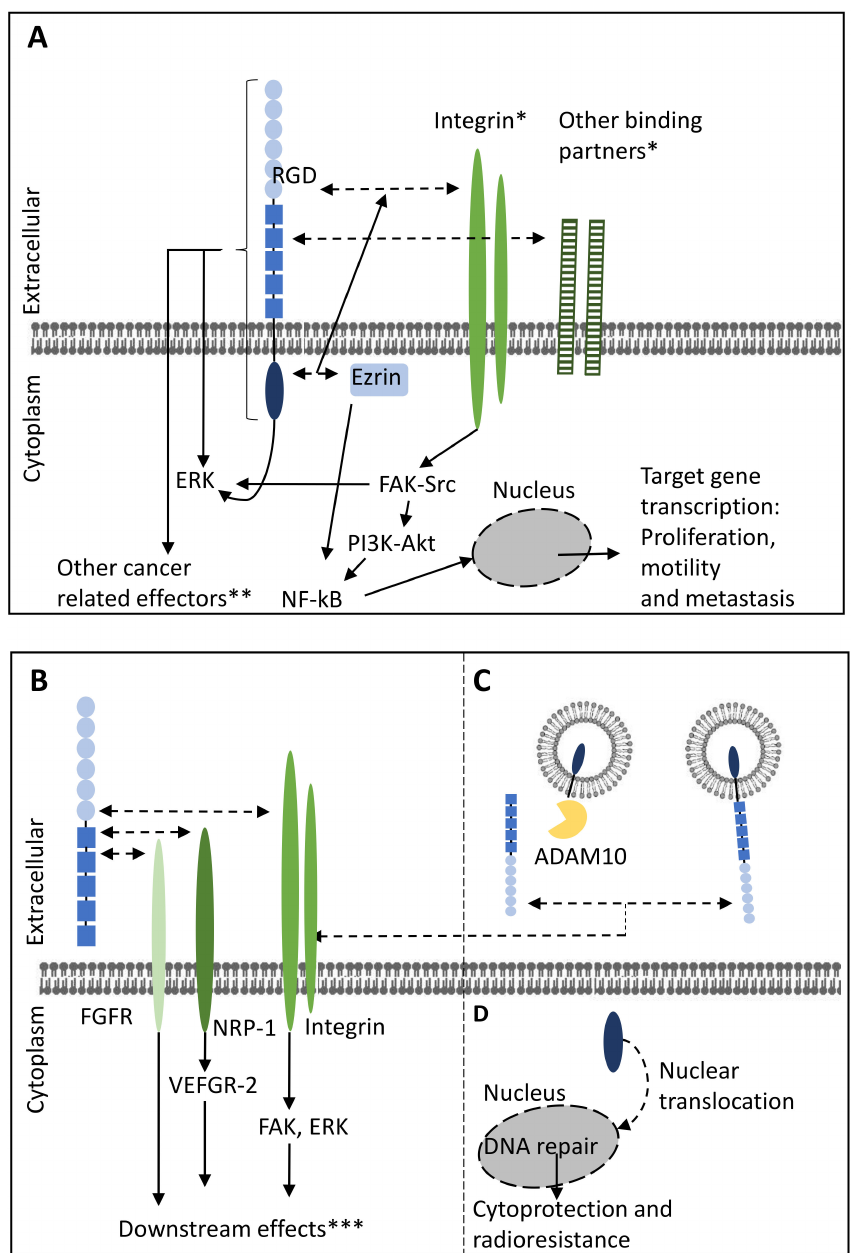
Figure 3. Schematic overview of the signaling pathways of full-length L1CAM in the plasma membrane and soluble forms of L1CAM and contribution to cancer progression-associated events. ( A ) Full-length L1CAM in the plasma membrane. ( B ) Soluble ectodomain of L1CAM. ( C ) Exosomal L1CAM. ( D ) Intracellular L1CAM. * Interactions between L1CAM and binding partners can occur in cis as well as in trans (not depicted). ** For example, JNK, Wnt-related e ff ectors and caspase 8. *** Such as cell motility, proliferation and angiogenesis. Solid arrows indicate induction of e ff ects. Dashed arrows indicate interactions possibilities. ADAM: A Disintegrin and metalloproteinase domain-containing protein, Akt: protein kinase B, ERK: extracellular signal-regulated kinase, FAK: focal adhesion kinase, FGFR: fibroblast growth factor receptor, JNK: c-jun n-terminal kinase, MMPs: matrixmetalloproteinases, NF- κ B: nuclear kappa-light-chain-enhancer of activated B cells, NRP: neuropilin, PI3K: phosphatidylinositide 3-kinase, RGD: Arginylglycylaspartic acid, STAT: signal transducer and activator of transcription, VEGFR: vascular endothelial growth factor receptor, Wnt: wingless-related integration